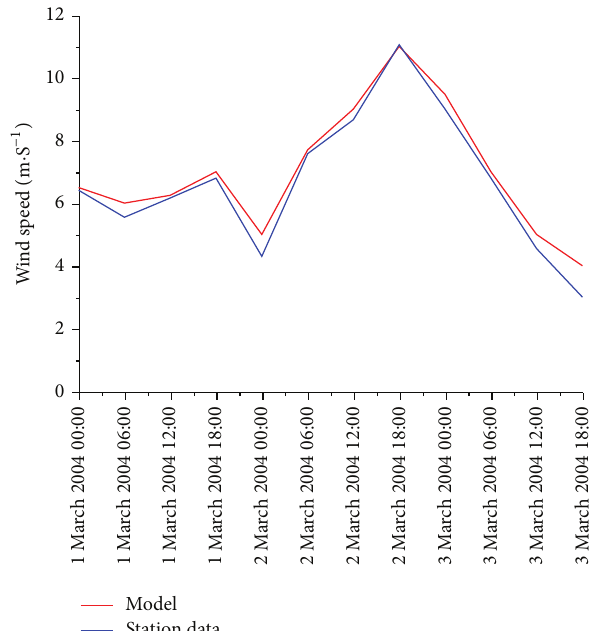
Figure 11: Comparison of wind speed at 10 meters high of (OT) station with the model results from 1 to 3 March 2004. The observational (blue graph) and simulated wind speed data (red graph) showed a good correlation score of decreasing wind velocity on 3 March 2004.